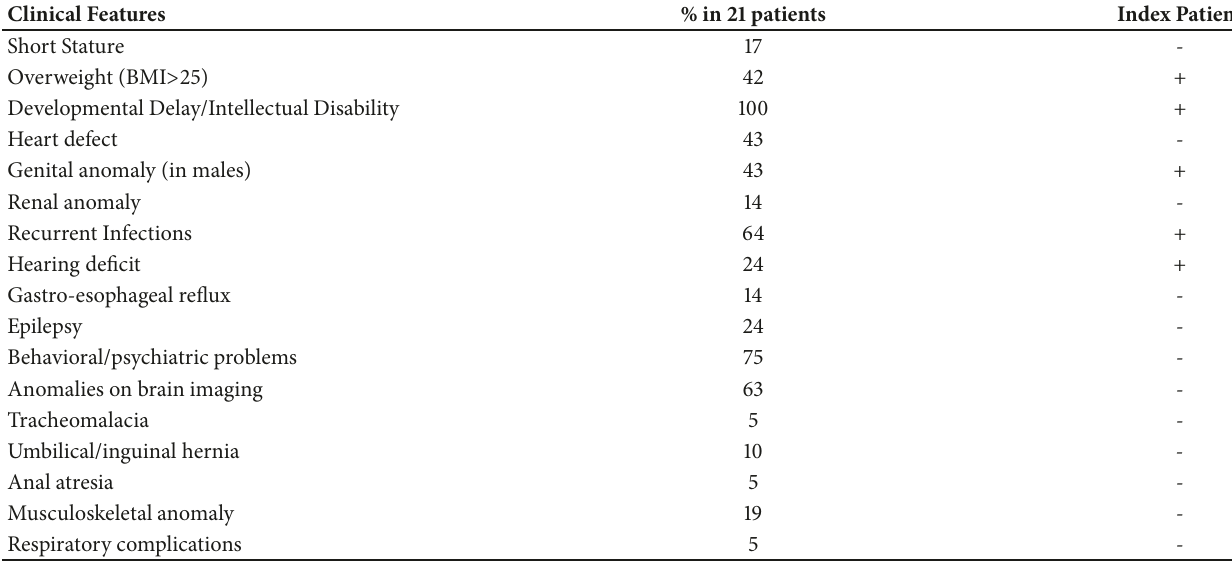
Table 4: Summary of clinical features seen in 21 patients [4] with EHMT1 mutations and in the index patient. Clinical